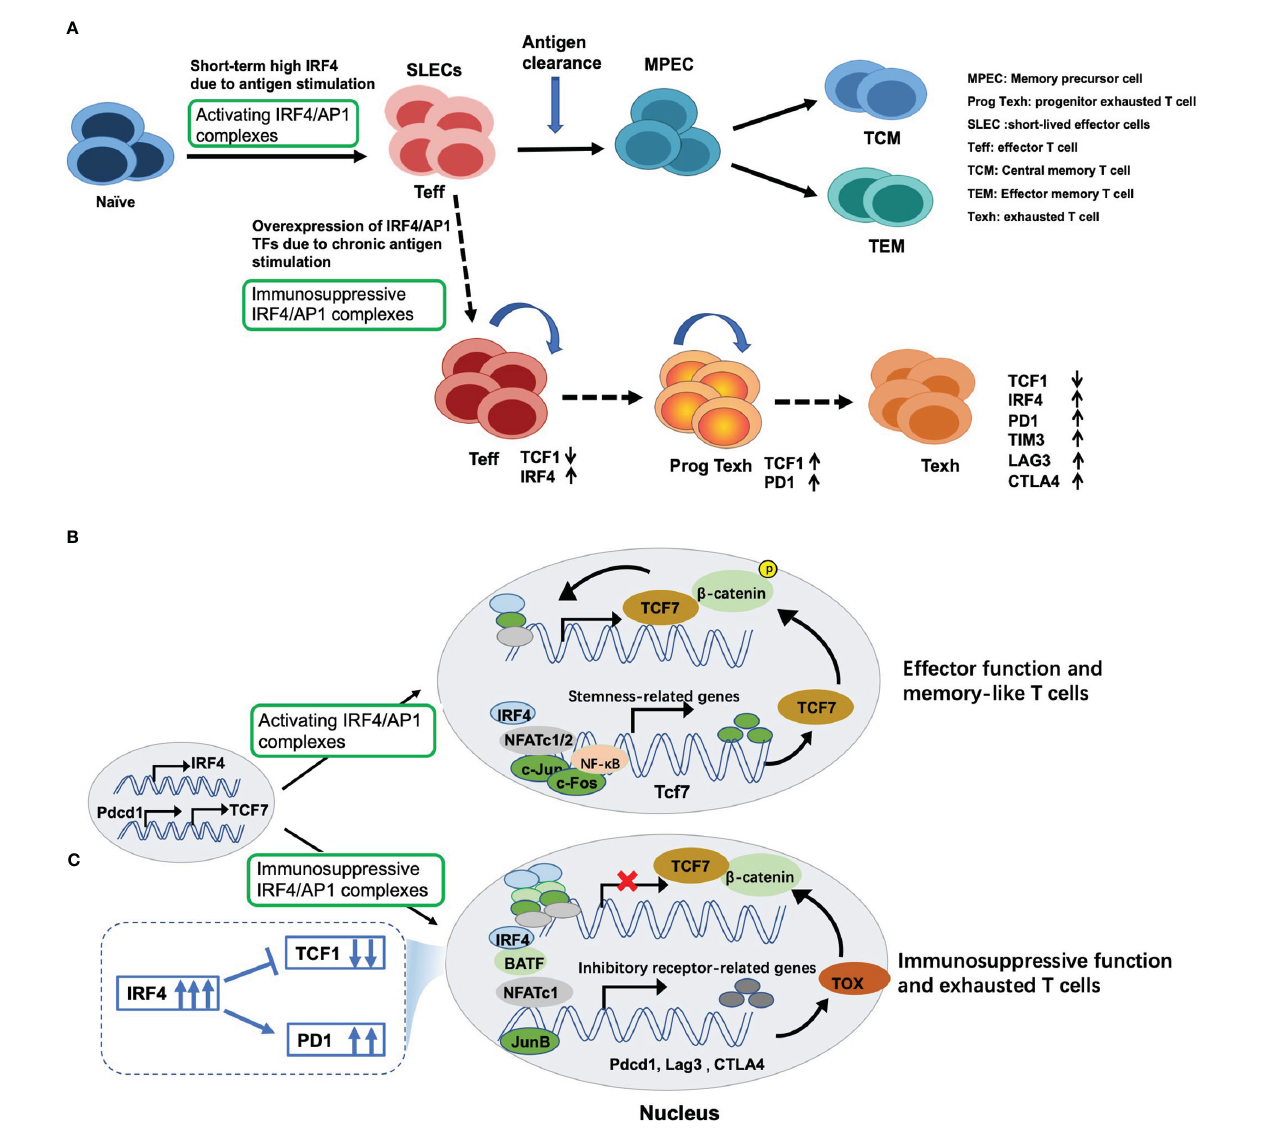
FIGURE 3 Dual regulatory effects of IRF4 on T cell immunity and underlying mechanisms. (A) Antigen stimulation drives and induces the expression of IRF4, which contributes to maintaining the expansion and sustained differentiation of effector CD8+ T cells. However, sustained overexpression of IRF4 due to chronic antigen stimulation drives CD8+ T cell exhaustion. Mechanically, (B) once antigen stimulation, IRF4 is induced and combined with its binding partners to form activating IRF4/AP1 complexes, thus inducing the production of effector cytokines and exerting cytotoxic activity. Once antigen clearance, the expression of IRF4 decreases, followed by an increase in expression of stemness-like gene TCF7 expression, thus producing TCF1+ memory-like T cells; (C) however, persistent overexpression of IRF4 and AP1 family members, such as BATF, BATF3 and JunB, leads to the formation of immunosuppressive IRF4/AP1 complexes, which opens multiple exhaustion-related chromatin regions, promoting the expression of inhibitory receptors and NR4A and TOX family members, which inhibits TCF7 expression and eventually drives CD8+ T cell